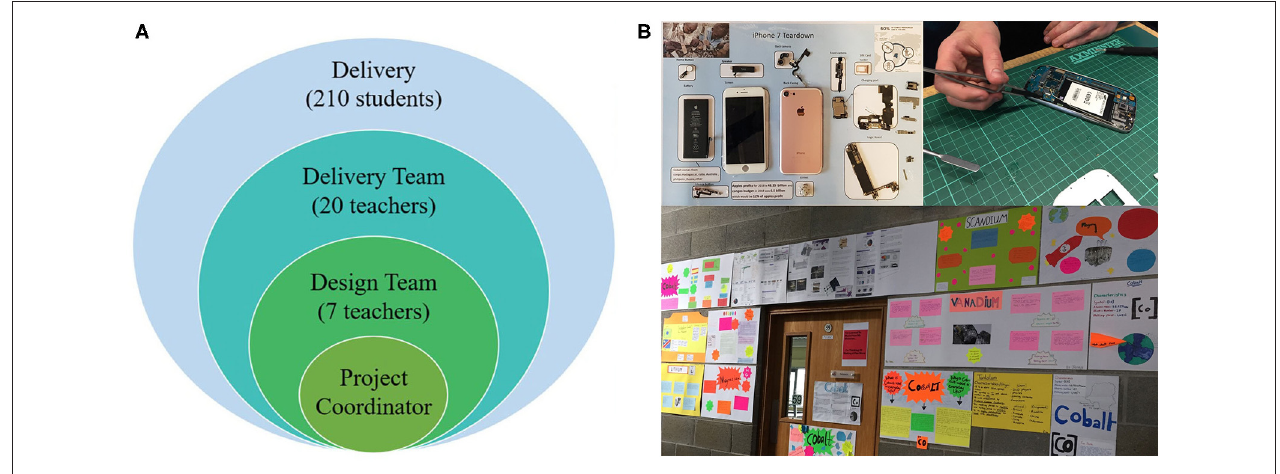
FIGURE 1 | Project delivery design (A) and E-mining@School project activities (B) .